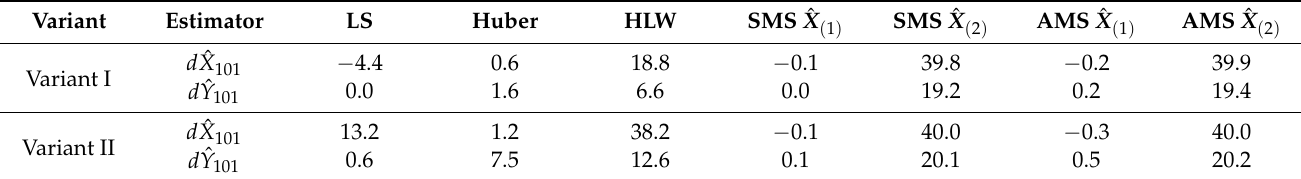
Table 3. Medians (mm) of the estimates of increments to point 101 coordinates from